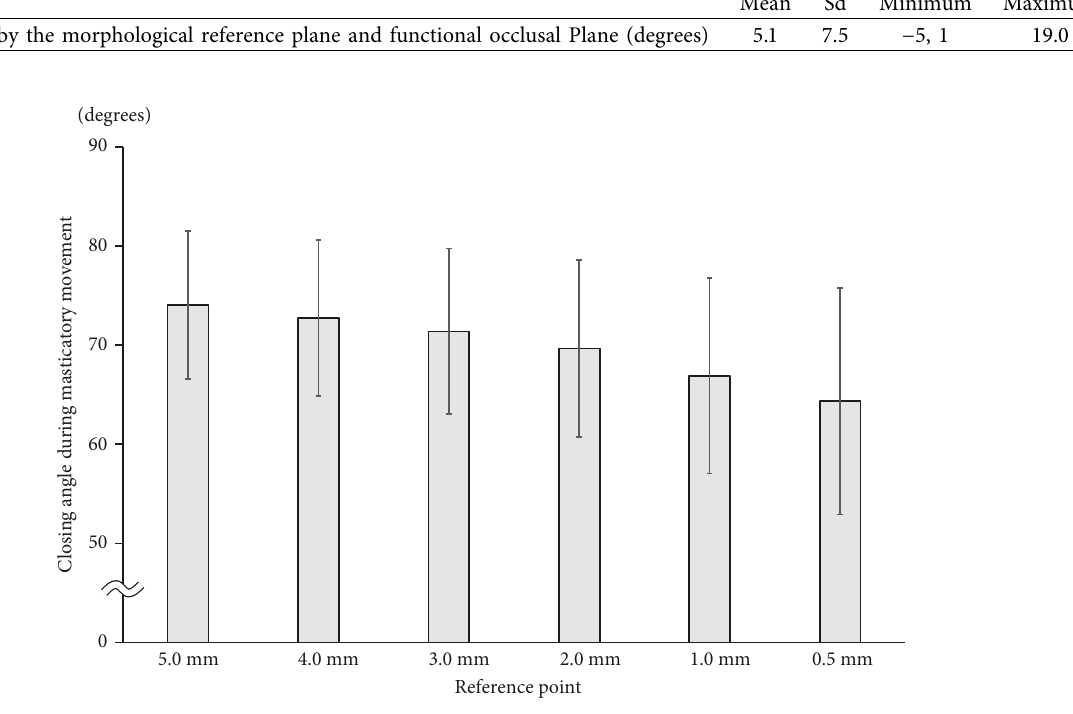
Figure 3: Closing angle during masticatory movement.